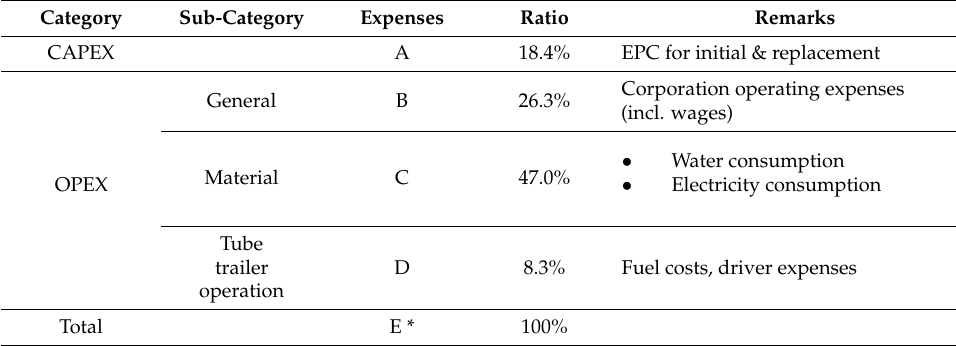
Table 14. Estimation of whole expenses and breakdown (Scenario